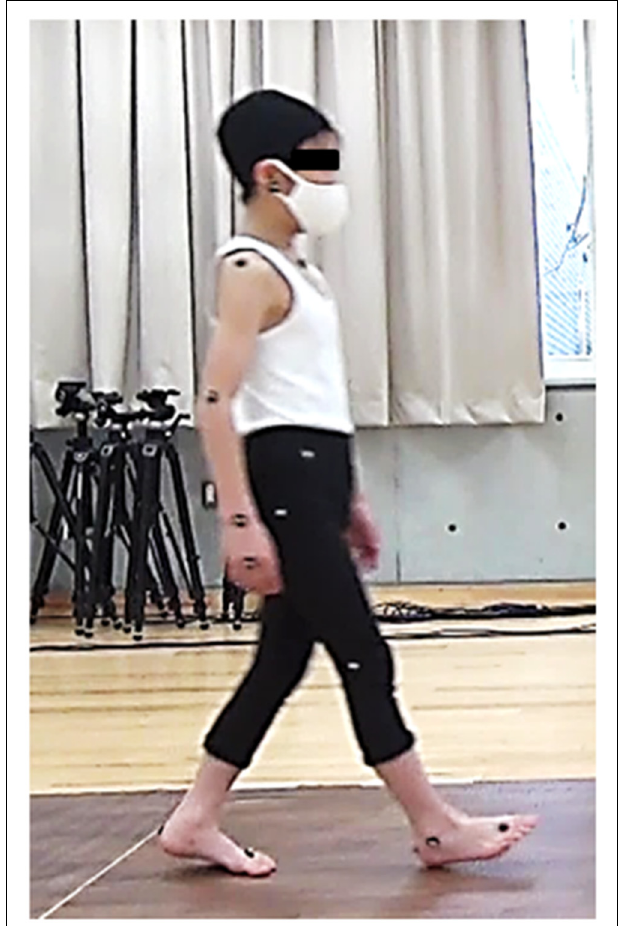
FIGURE 1 | Experimental setup: The participants walk barefoot at a self-selected walking speed along an 8 m walkway. Twenty-seven reflective markers are attached to bony landmarks.